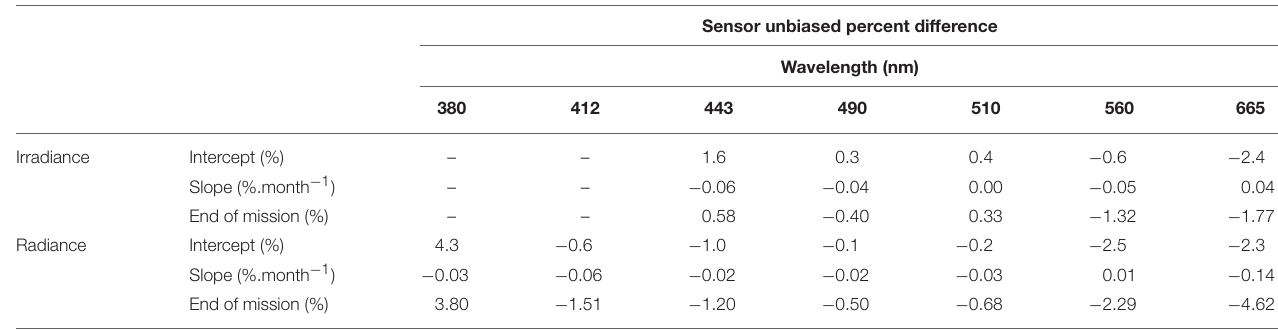
TABLE 4 | Intercept (initial values), slope and final values of all UPD over 480 days (float lovapm011b ).